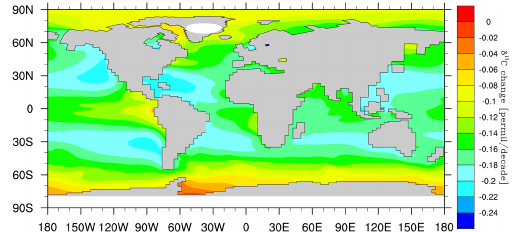
Figure 8. Surface ocean Suess effect (the change in δ 13 C) between 1970 and 1990, in ‰decade − 1